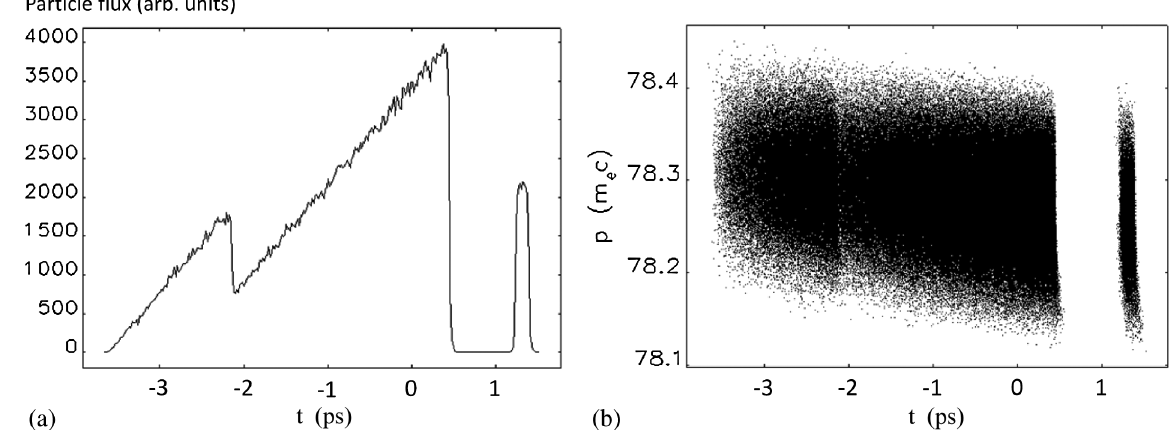
FIG. 8. Output beam, computation with a third-order real standing wave cavity matrix provided by Tech-X and imported into Elegant. Beam time profile (a) and momentum spread